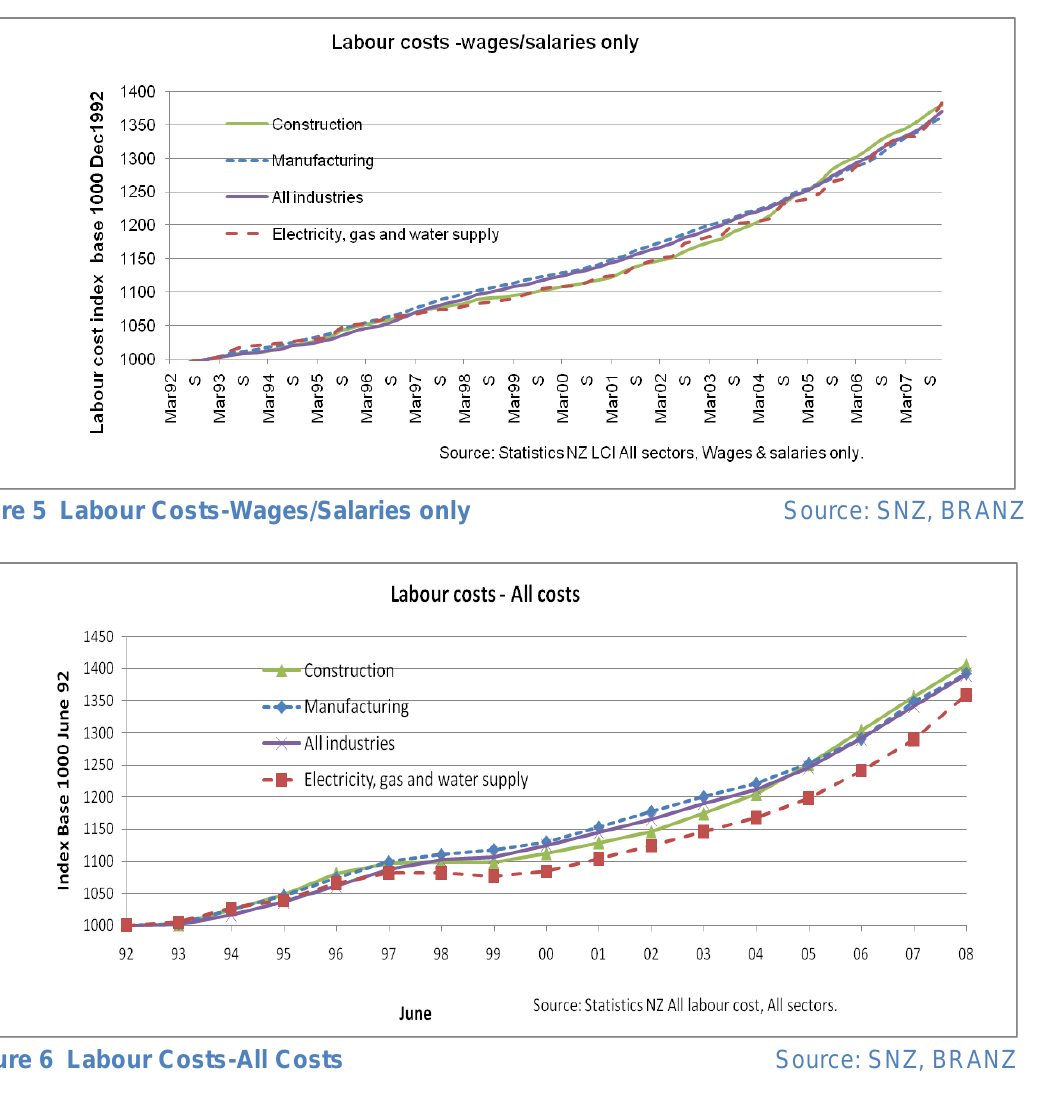
Figure 6 Labour Costs-All Costs Source: SNZ,